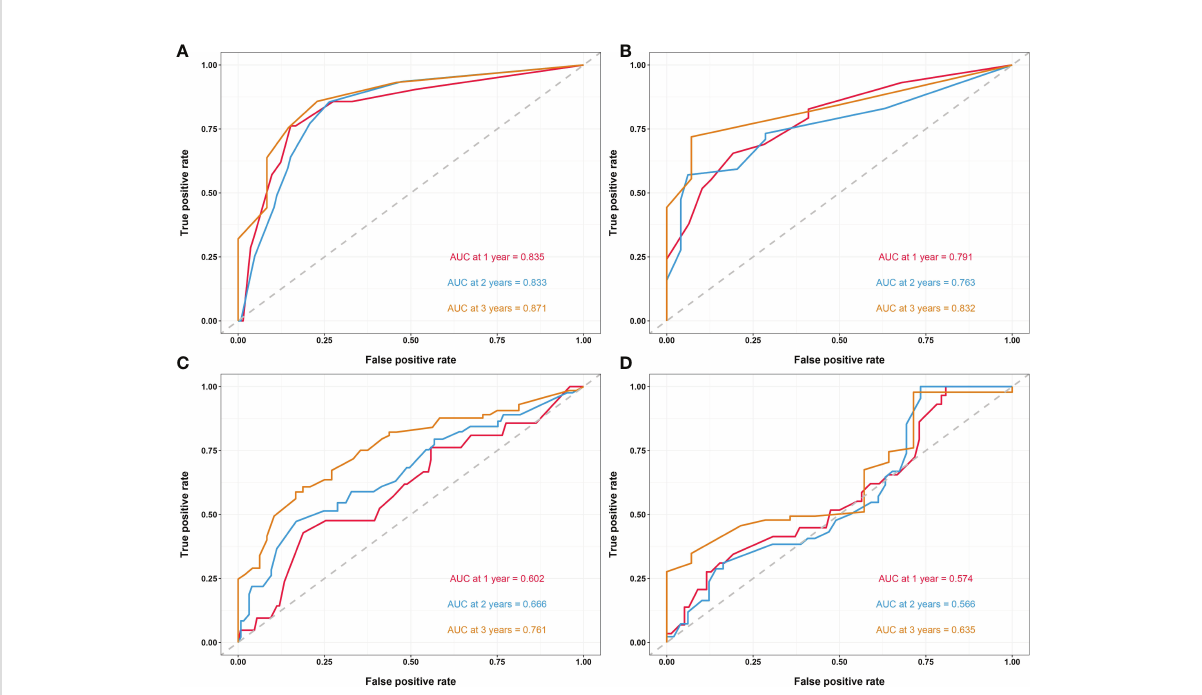
FIGURE 5 (A) Time-dependent ROC curves of the nomogram in the training cohort. (B) Time-dependent ROC curves of the nomogram in the external validation cohort. (C) Time-dependent ROC curves of model 2 in the training cohort. (D) Time-dependent ROC curves of model 2 in the